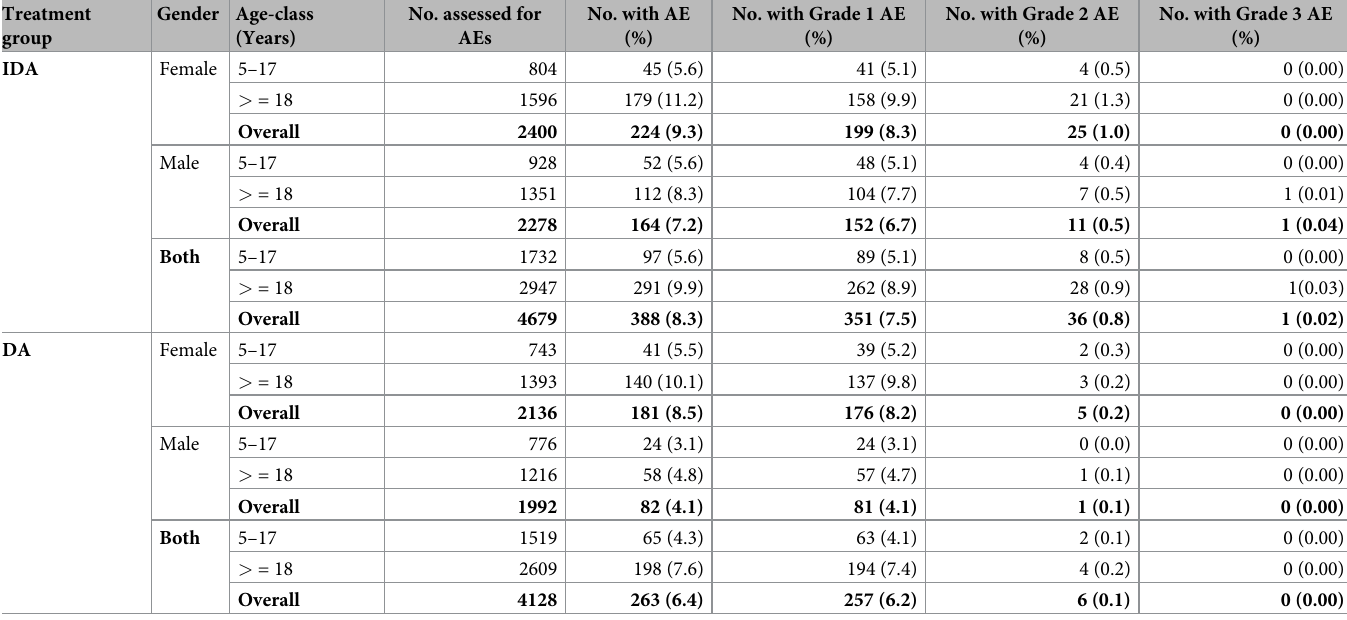
Table 4. Adverse events by age-group, gender and treatment regimen. Treatment